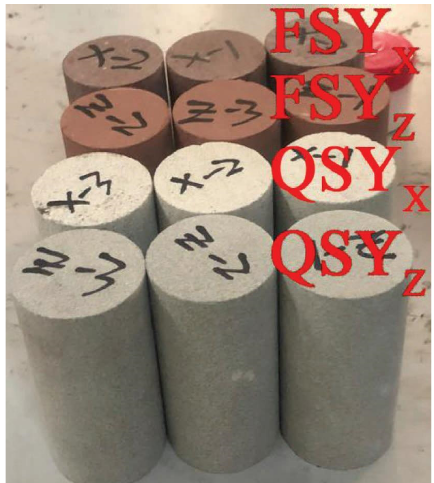
Figure 1: Original sandstone samples with different